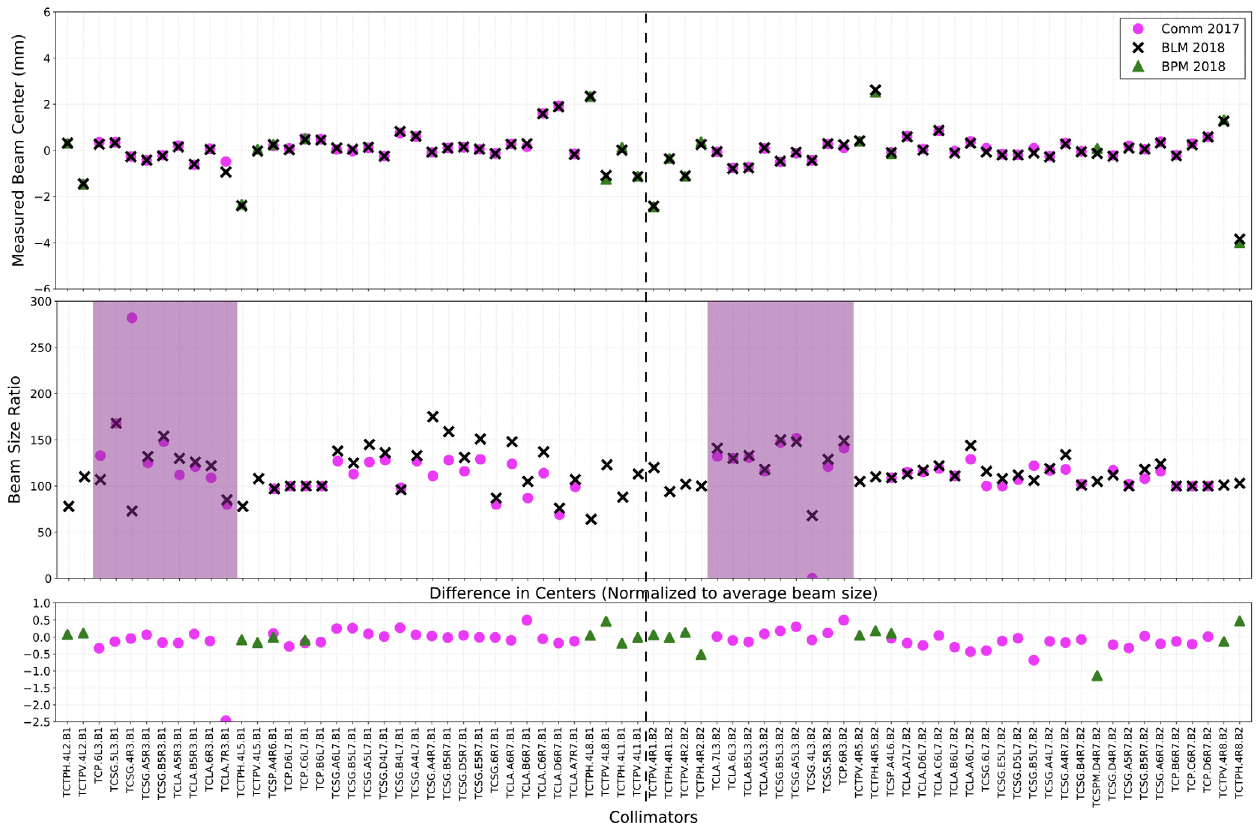
FIG. 10. Flattop BLM commissioning 2018 results, comparing the beam centers to 2018 BPM centers and 2017 BLM centers (top graph), beam size ratios compared to 2017 (middle graph), and comparison of the difference in centers normalized by the average beam size (bottom graph).